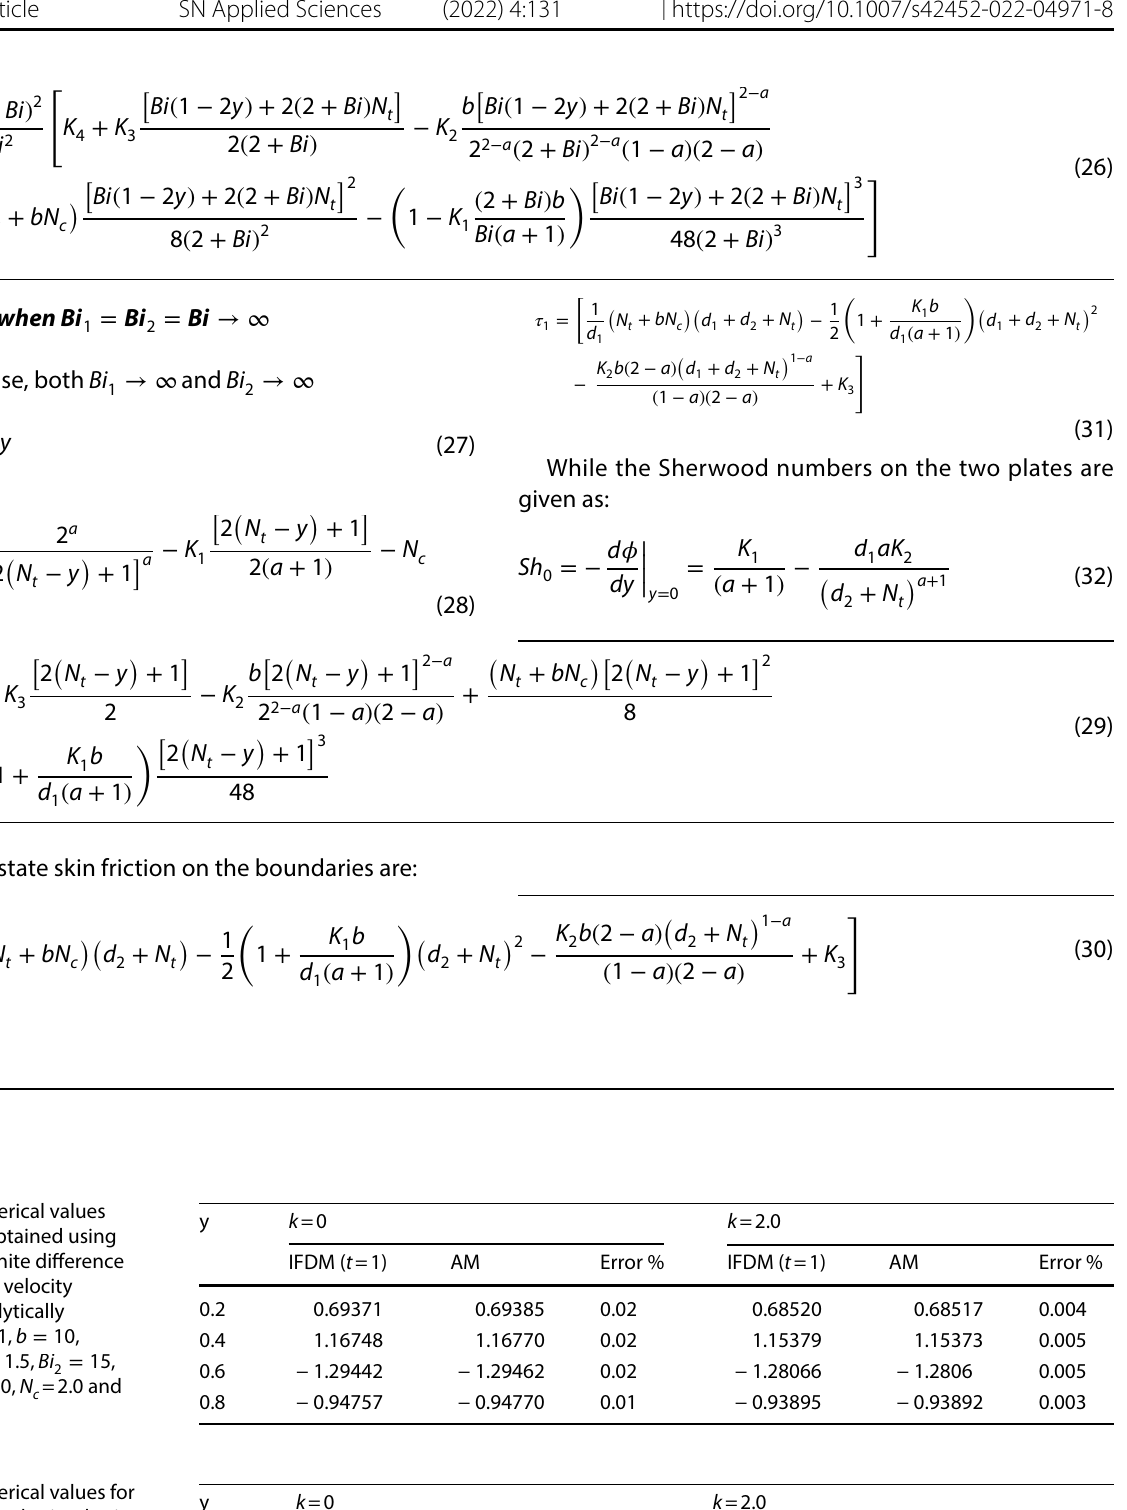
Table 2 Numerical values for concentration obtained using the implicit finite difference at t = 1.0 and concentration obtained analytically when Pr = 0.71, Sc = 0.6, = 1.5, Bi = 15, N = 2.0 Bi 1 2 c and N t =